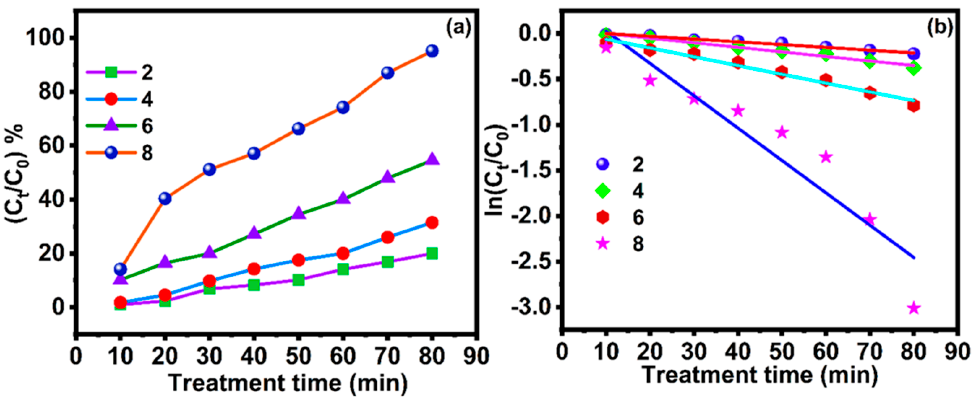
Figure 9. Effect of ( a ) photocatalyst concentration on degradation of MCP and ( b ) pseudo-first-order kinetic reaction rate constant .